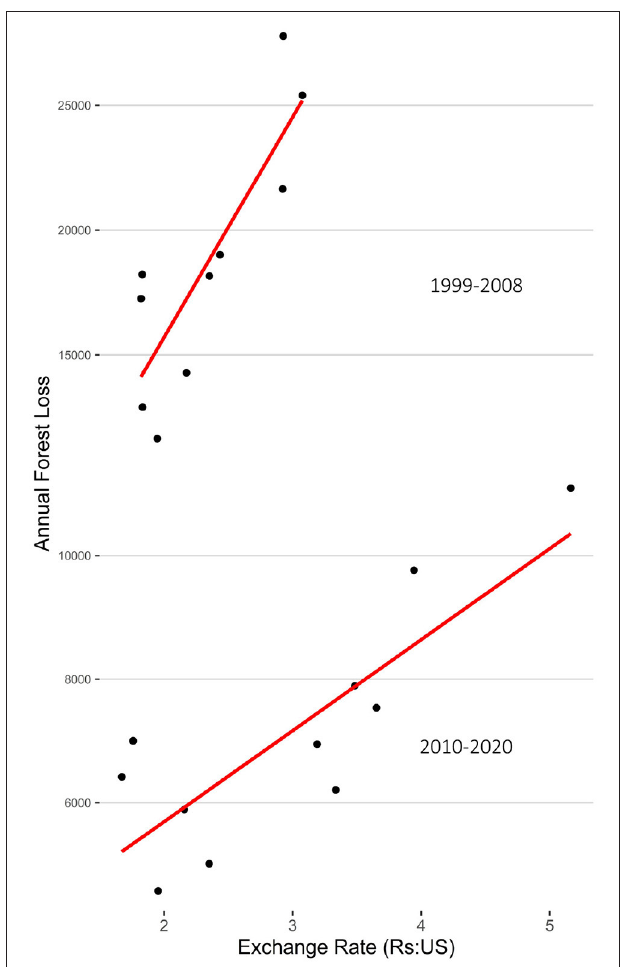
FIGURE 3 | The strength of the real has closely correlated with forest loss in the Amazon. Both pre-2009 (top figure) and post-2009 (lower figure), forest loss correlated with the value of the Brazilian real. Prior to 2009, each 1% change in the value of the Brazilian real (measured against US dollars) was associated with a 1.1% change in deforestation. Since 2010, each 1% change in the currency value was associated with a 0.52% change in forest loss. Each point in the figure represents the average exchange rate and total Amazon forest loss during a given year. Author’s calculations based on data from PRODES and (FRED,